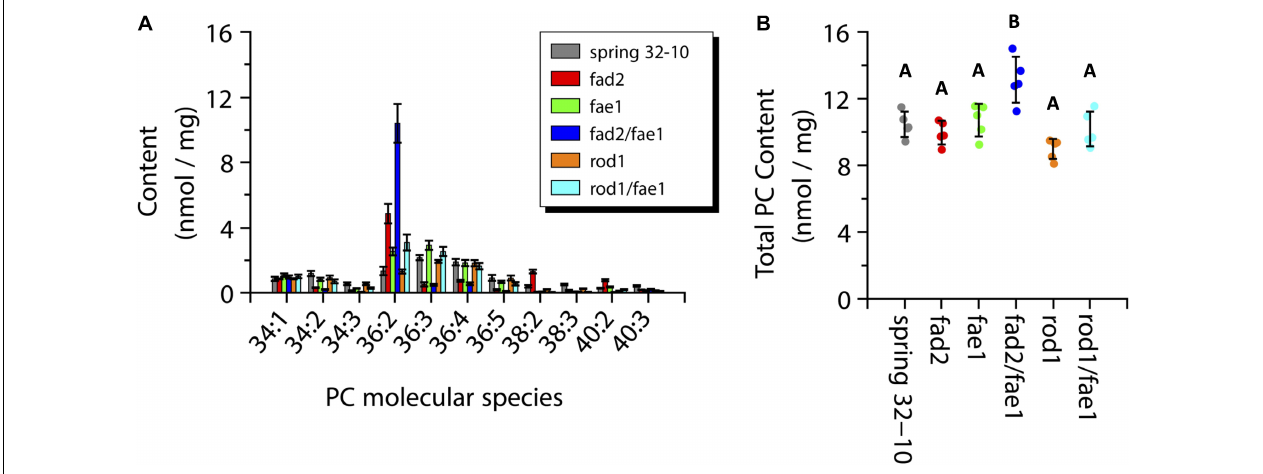
FIGURE 8 | Measurements of phosphatidylcholine (PC) molecular species composition (A) and total PC content (B) within wild-type Spring 32-10 (dark gray) and CRISPR/Cas9 mutant T. arvense seeds fad2 (red), fae1 (green), fad2 fae1 (dark blue), rod1 (orange), and rod1 fae1 (light blue). Error bars represent standard deviations of the means ( n = 5, ± SD, one-way ANOVA; Tukey test, p < 0.01).